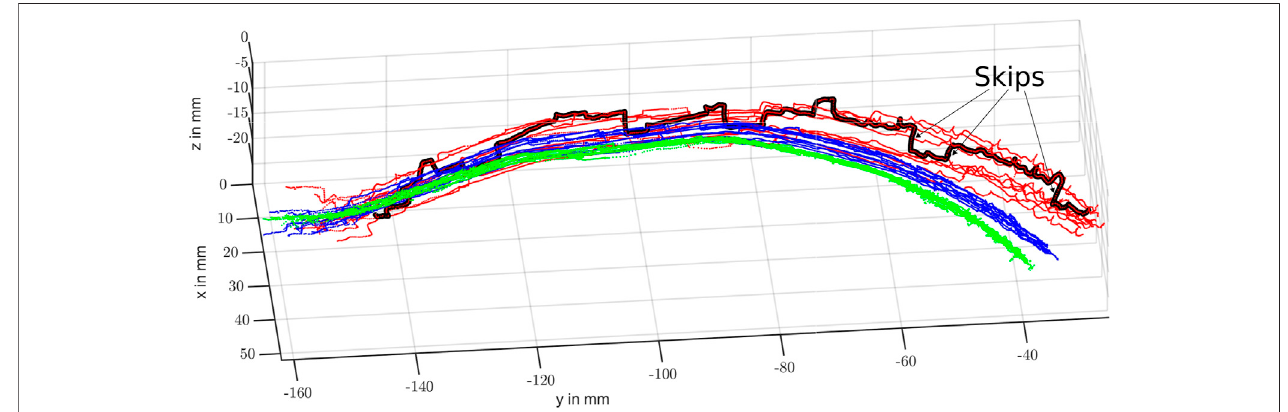
FIGURE 7 | Resulting scans of the curved vessel branch using pure PSM-based (red), IMU-PSM-fused (blue) and IR tracked (green) kinematics. One of the PSM kinematic-based scans with particularly large skips is highlighted in black.